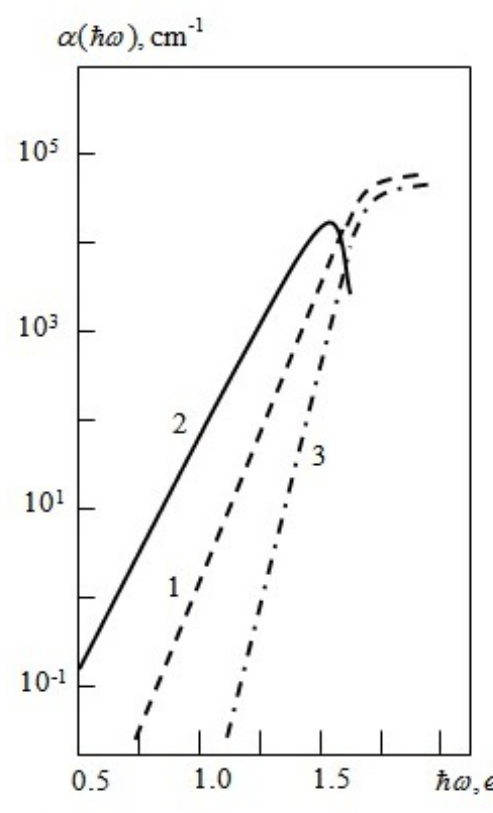
Fig. 1. Graphs of partial absorption coefficient spectra corresponding to optical electronic transitions, 1 - from the tail of the valence zone to the conduction zone, 2 - from the tail of the valence zone, to the tail of the conduction zone, 3 - from the valence zone, to the tail of the conduction zone. The calculations were carried out for ε C − ε 0 = 0.7 eV ; E g = 1.8 eV ; β 1 = 16 eV − 1 and β 2 = 25 eV − 1